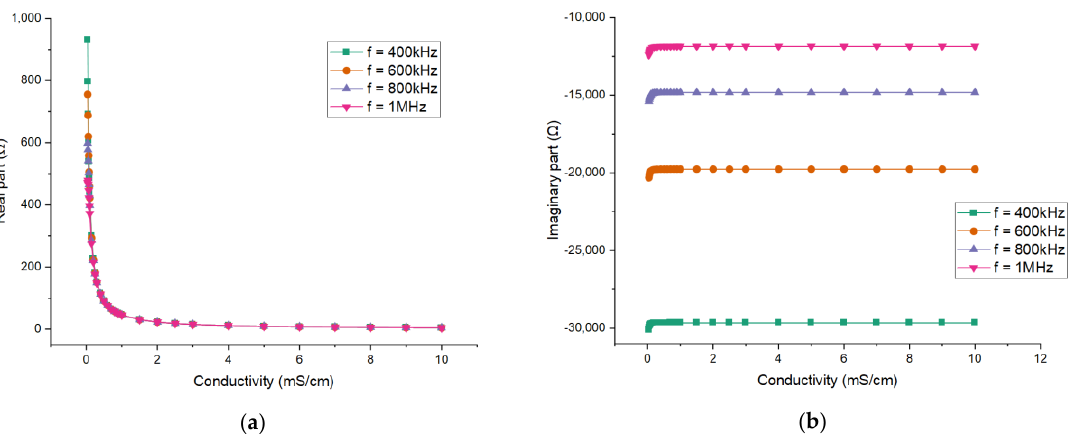
Figure 7. Simulation results for different excitation frequencies: The dependence of ( a ) the real part of the impedance; ( b )